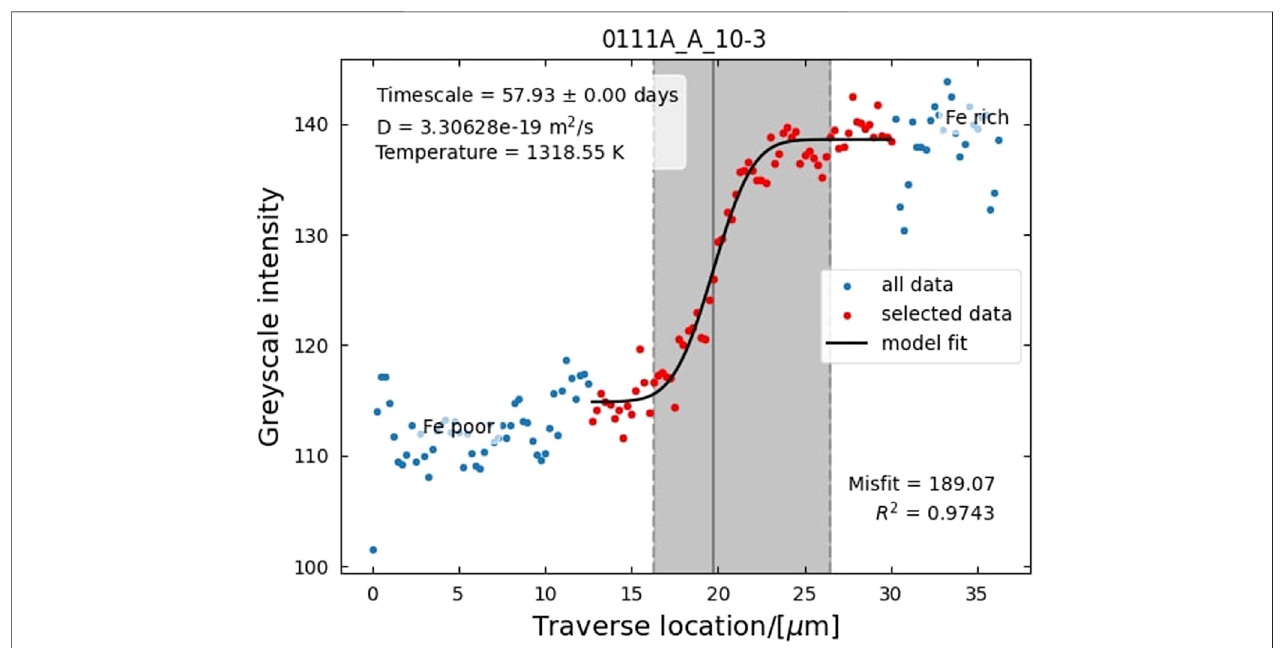
FIGURE 5 | SEM greyscale intensity as a function of traverse location extracted from the SEM image for a sample from the 1010 Cal. CE eruption (blue dots), the data selected for fi tting bythe model (red dots), and the model solution (black line). Also shown are the fi tted parameters (timescale, diffusion coef fi cient, D, and effective temperature), the theoretical pro fi le midpoint ( μ – gray line), and the “ goodness-of- fi t ” (R). The gray shaded area represents the mean ± 1 SD of the selected data.